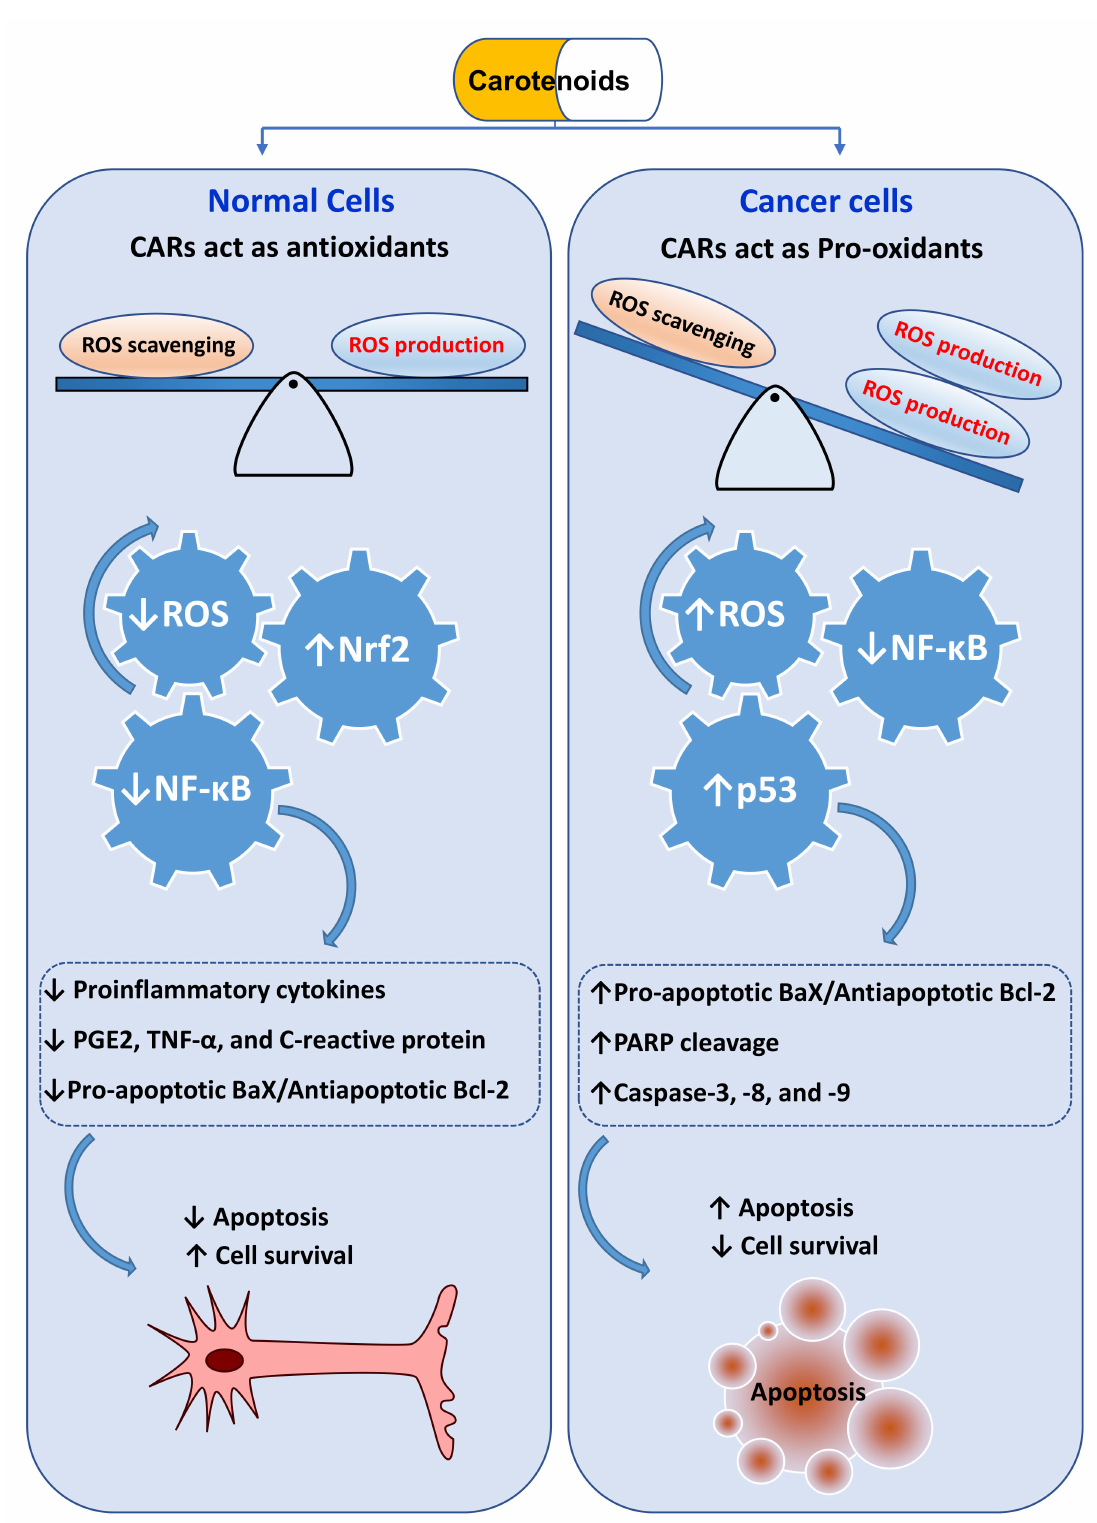
Figure 6. The antioxidant (in normal cells) and pro-oxidant properties of carotenoids regulate the reactive oxygen species (ROS) and modulate the nuclear factor kappa-light-chain-enhancer of activated B cells (NF- κ B); nuclear factor-erythroid 2-related factor 2 (Nrf2), responsible for apoptosis of cancer cells; and survival of normal cells. Abbreviations: BAX, B-cell lymphoma 2 associated X; Bcl-2, B-cell lymphoma 2; PARP, poly (ADP-ribose) polymerase; PGE2, prostaglandin E2; TNF- α , tumor necrosis